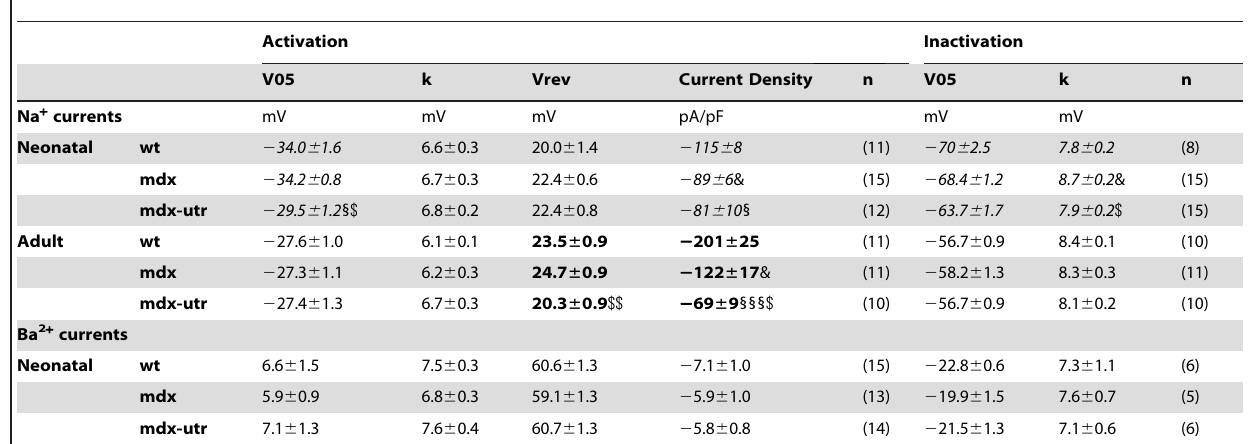
Table 1. Sodium and barium current parameters in wt and dystrophic